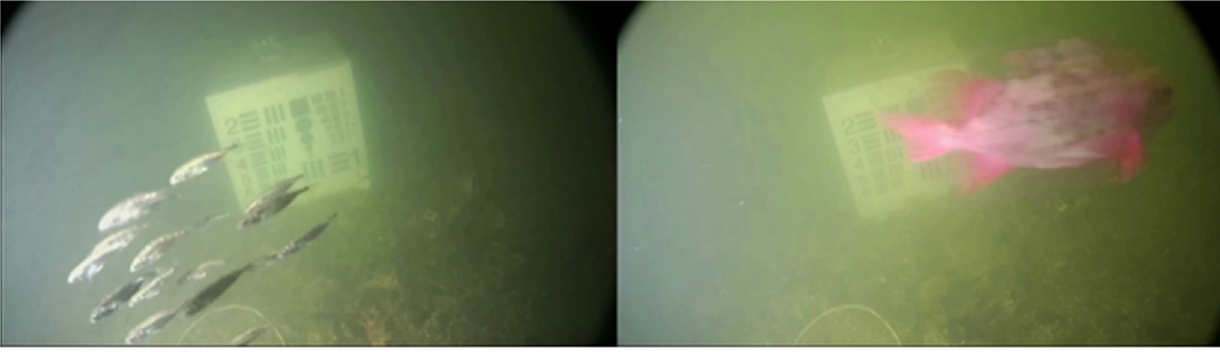
Figure 12. Original images of the brackish dataset.